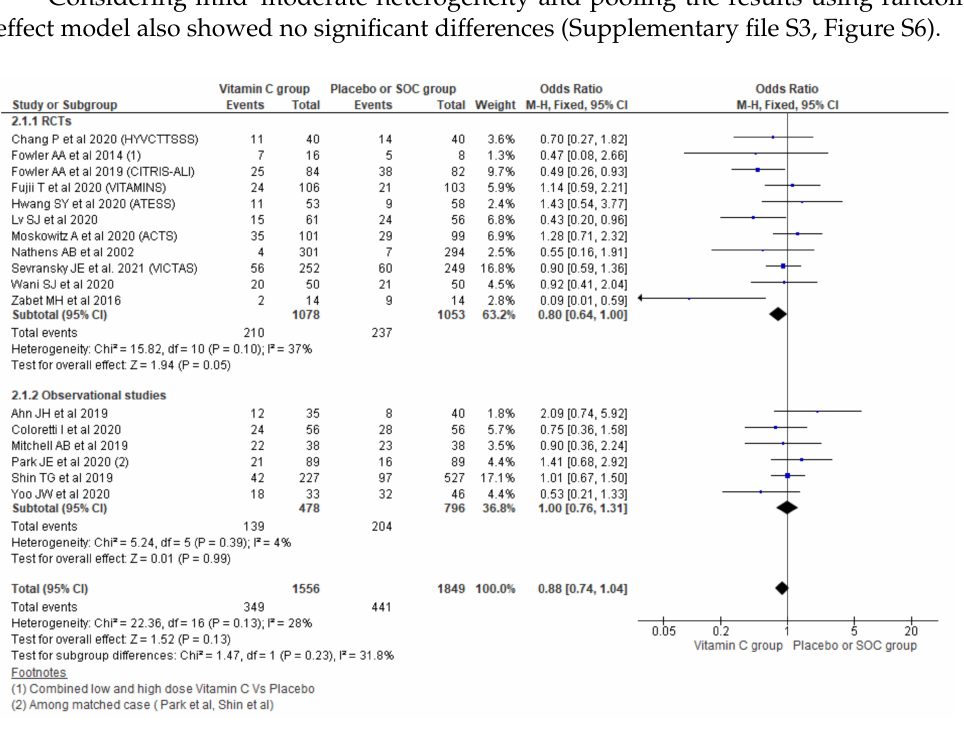
Figure 4. Forest plot showing 28-days mortality using fixed-effect